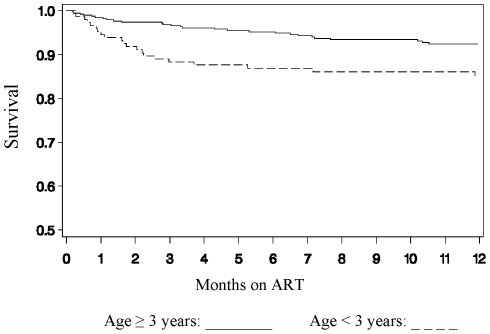
The age-stratified Kaplan-Meier graph of survival after ART initiation.